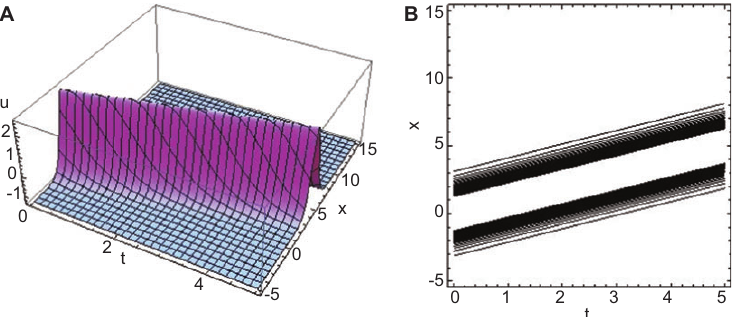
Figure 12 Boussinesq wave equation by using Mathematica ® : 3D plot (A) and contours (B) for k = ν = α =